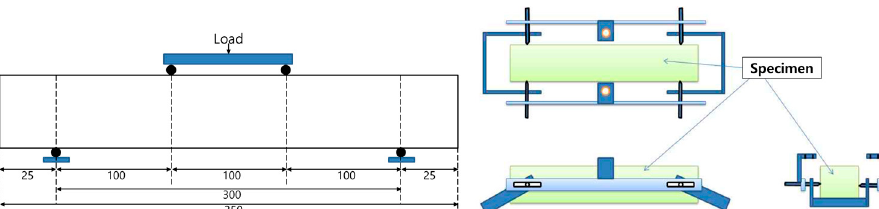
Figure 2. Drawing of the specimen and Japanese yoke for linear variable differential transducers (LVDTs).